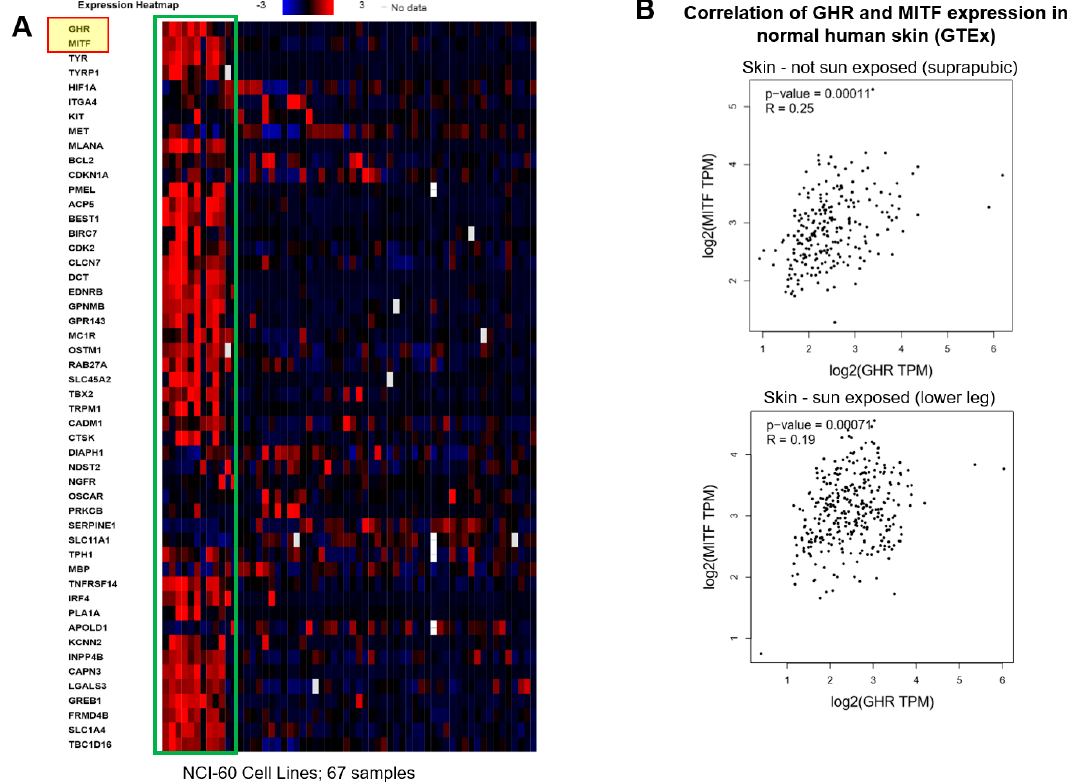
Figure 7. Bioinformatic analysis: GHR, MITF, and MITF target genes coexpress and strongly cluster in the human sample datasets. ( A ) Heatmap shows normalized RNA expression (FRKM) values of GHR, MITF, and 48 MITF target gene expression in all the samples of National Cancer Institute’s NCI-60 cancer cell panel. Green box indicates clustering of GHR, MITF, and MITF targets. Supplementary Figure S7 shows similar analyses for the CCLE (Cancer Cell Line Encyclopedia) dataset. ( B ) Correlation (Pearson’s) analysis of GHR and MITF RNA expression in the GTEx (Genotype Tissue Expression) human post-mortem dataset containing samples from 53 non-diseased tissue sites for nearly 1000 individuals using the GEPIA platform. A positive and highly significant correlation between GHR and MITF expression in sun-exposed (lower-leg; Pearson coe ffi cient = 0.19, p = 0.00071) and not sun-exposed (suprapubic; Pearson coe ffi cient = 0.25, p = 0.00011) normal human skin was